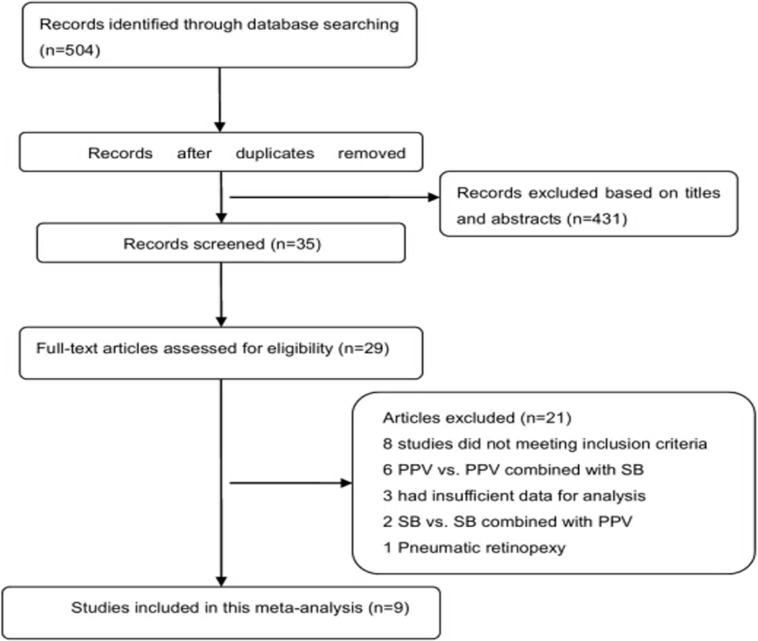
Flow chart of the articles selection process.